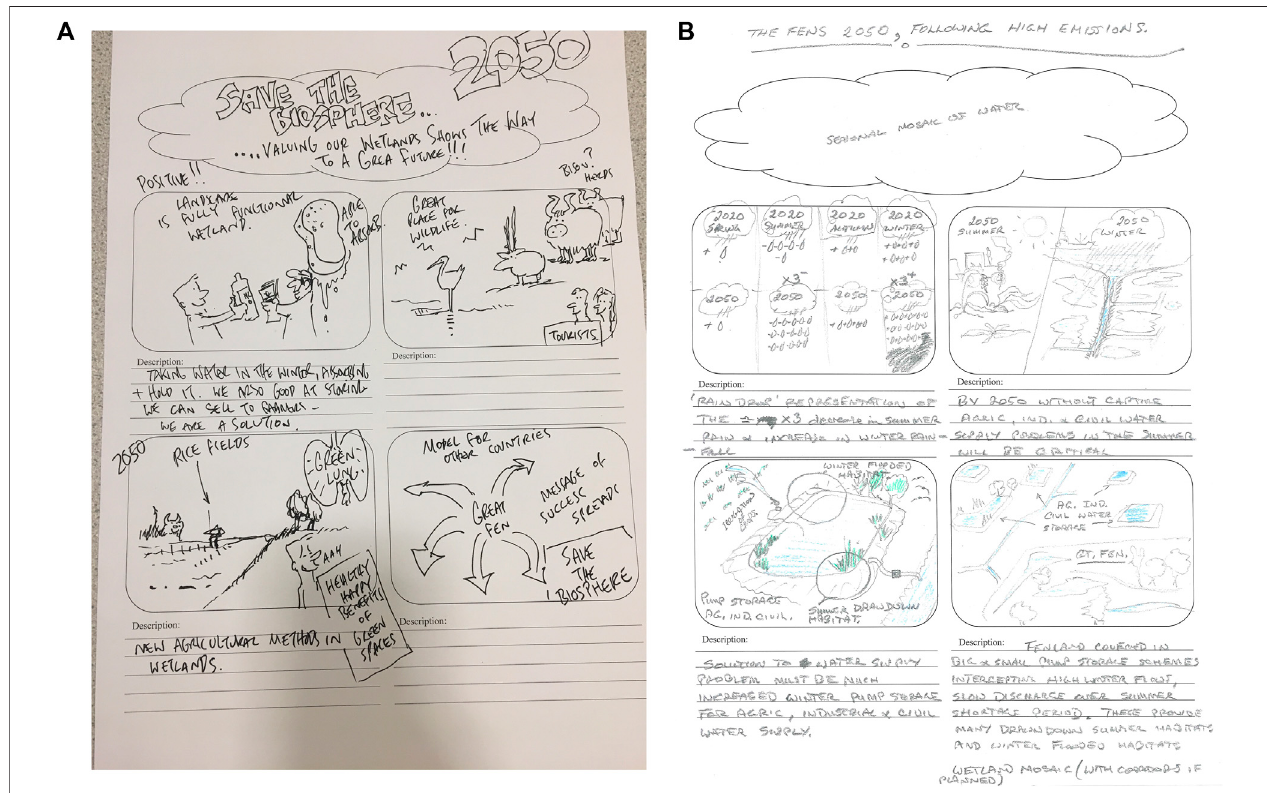
FIGURE 2 | (A,B) A storyboard created during a public engagement event in the Bevills Leam catchment.